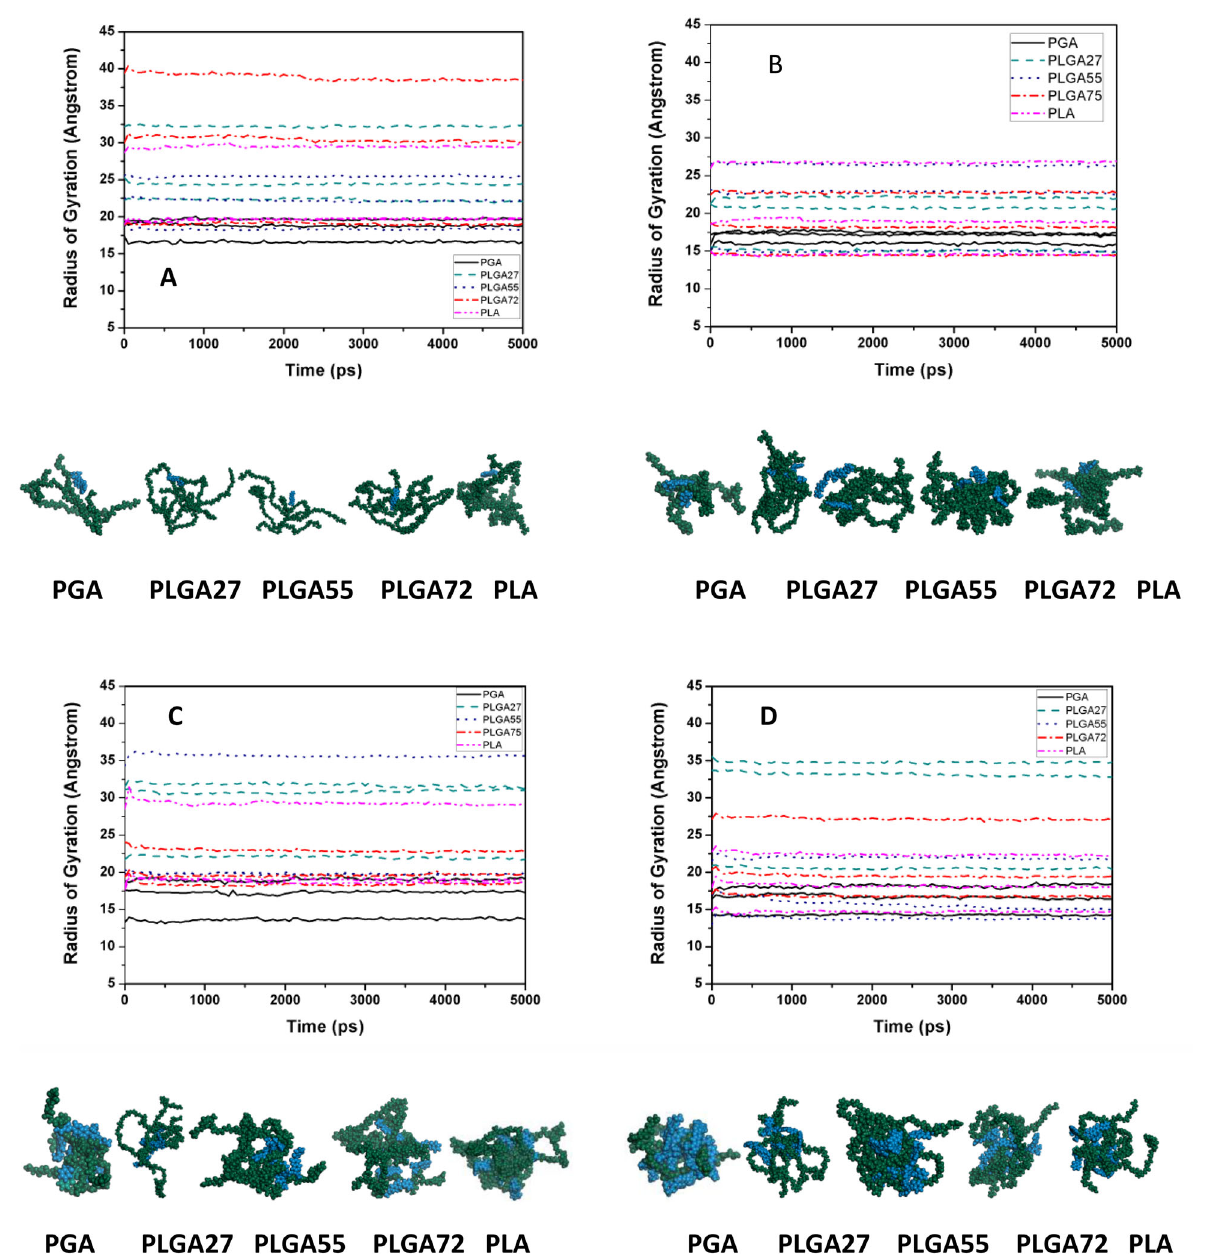
Fig. 12 Change in radius of gyration of the polymer chains during the course of simulation time of 5 ns for A three 50mer chains of each polymer type with one coumarin-6 molecule, B three 50mer chains of each polymer type with three coumarin-6 molecule, C three 50mer chains of each polymer type with sixcoumarin-6 molecule, and D three